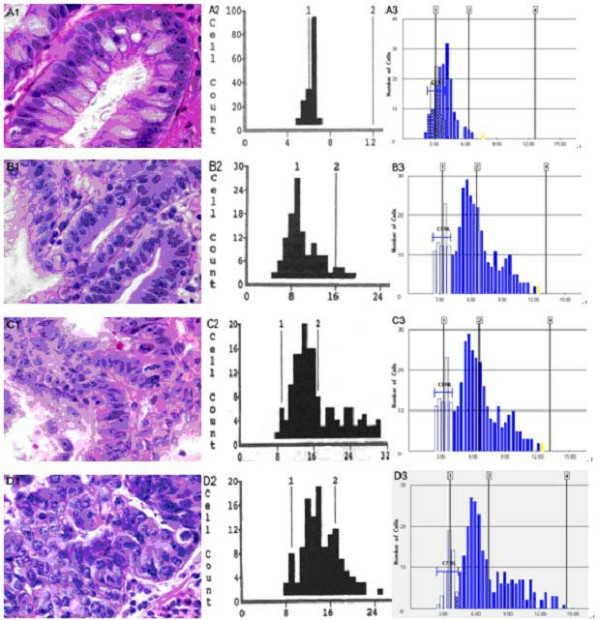
DI histograms generated by the CAS 200 (the middle column) and ACIS (the right column). The left column shows typical histology of the Barrett's related lesions (H&E stained, 400×) including specialized intestinal metaplasia without dysplasia (row A), low-grade dysplasia (row B), high-grade dysplasia (row C), and adenocarcinoma (row D). The corresponding DI histograms showed progressive increases in DNA content as disease progressed. On each DI histogram, the Y axis represents the number of total cells included and the X axis shows changes in DNA content in arbitrary units.